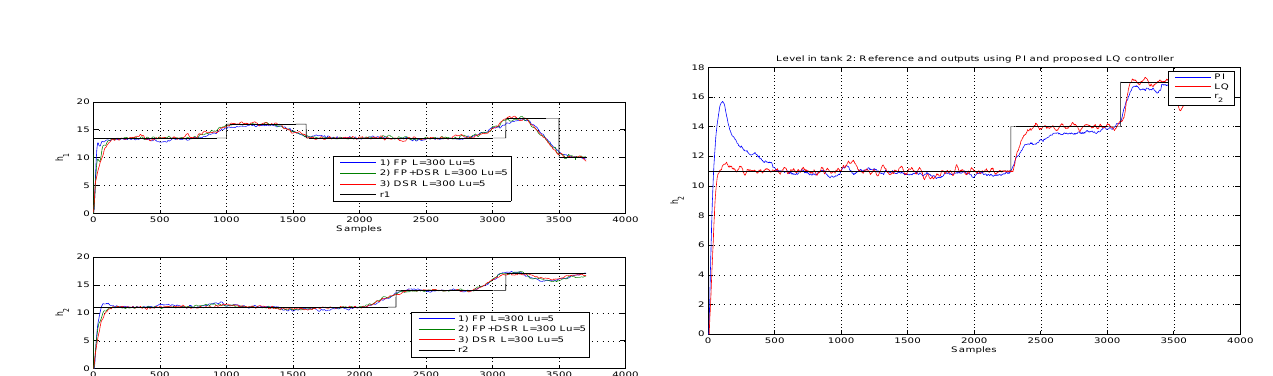
Figure 6: Quadruple tank process. Level in tank one upper and tank two lower. Illustrating the reference and the outputs from the process controlled by the proposed MPC controller, for three different cases. Case 1: FP model used in EKF to estimate the present state and linearized FP model in the MPC. Case 2: FP model used in EKF to estimate the present state and identified DSR model in the MPC. Case 3: DSR model and the corre- sponding Kalman filter used to estimate the present state and DSR model in the MPC.